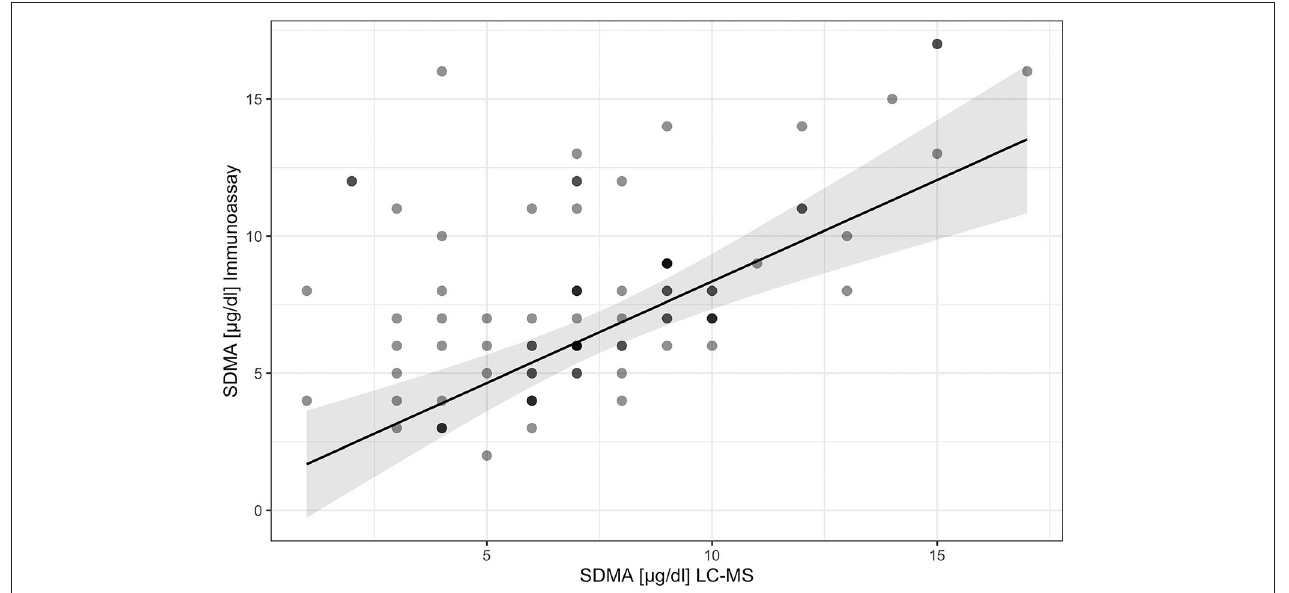
FIGURE 5 | Scatterplot with regression line: comparison of the two measurement methods for SDMA.